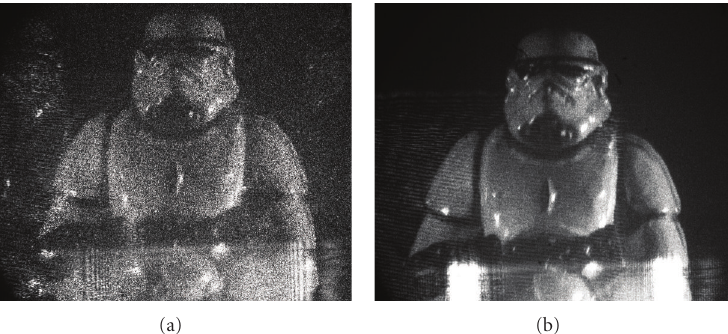
Figure 16: Removal of speckle noise in optoelectronic reconstruction by CCD integration of reconstructed images: (a) reconstruction from one image, (b) reconstruction from ten images.